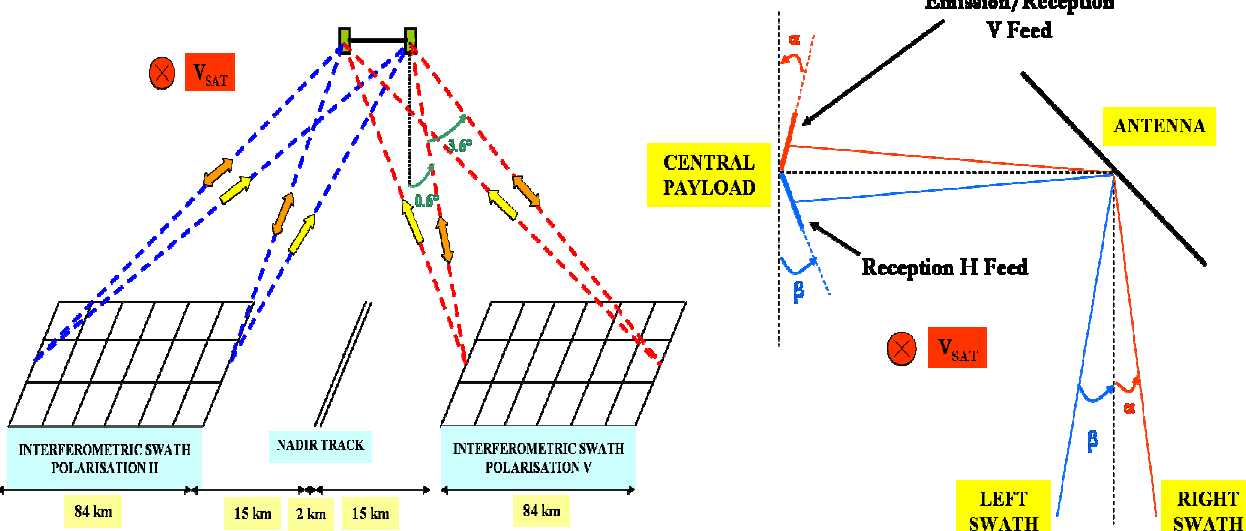
Figure 1. (a) Lay-out of the geometry of observation (b) Antenna and feeds configuration arbitrarily for the right swath; on the other side, feeds’ polar are reversed (Emission/Reception H Feed and Reception. V Feed); a V-polarization pulse is emitted by one antenna, and the consecutive pulse, with H-polarization, is emitted by the second antenna; both polarizations are received by the two antennas.